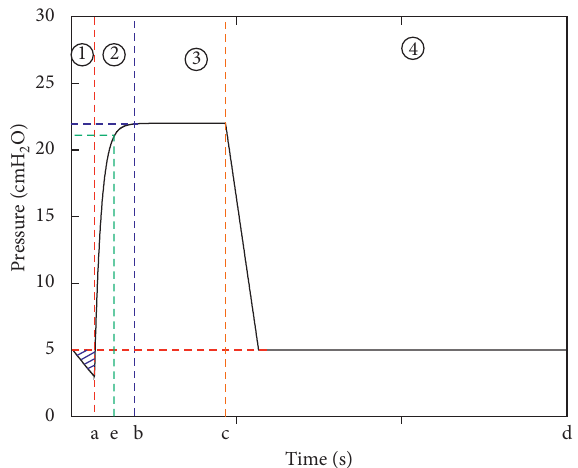
Figure 13: Four phases of a breathing cycle. a: t termination of a breathing cycle; e: t